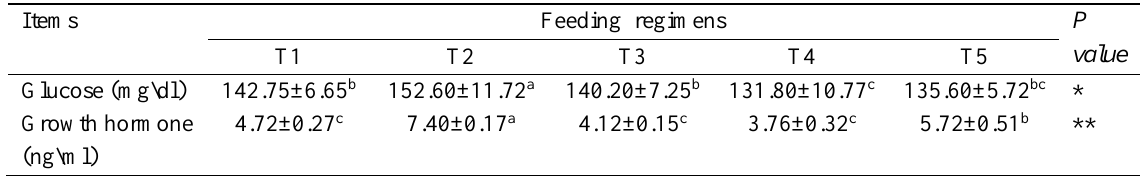
Table 9: Effect of feeding frequency and amount on growth hormone and glucose concentration of broiler